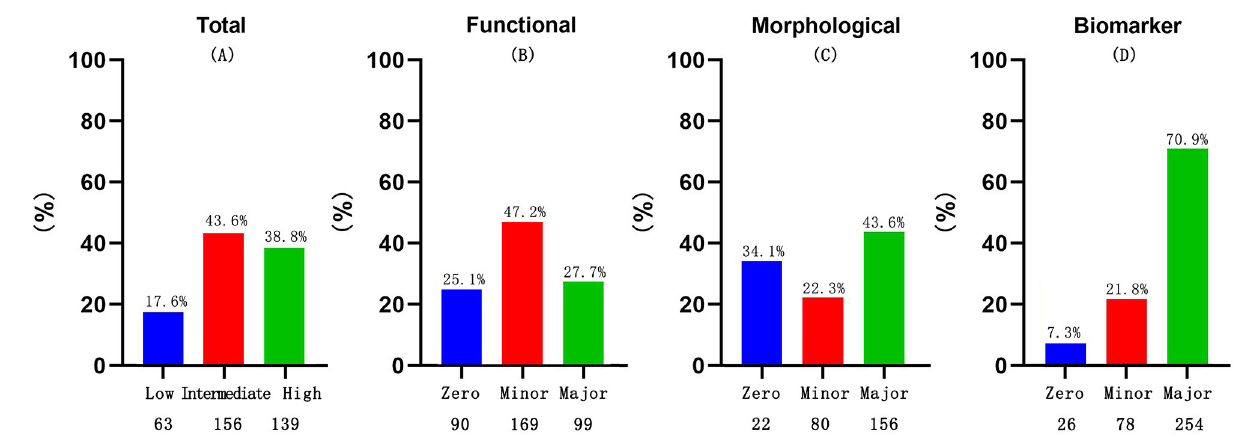
FIGURE 2 | Discriminates between the major and minor criteria for total HFA-PEFF score categories (A) , functional (B) , morphological (C) and biomarker sub-scores (D) , among the cohort.